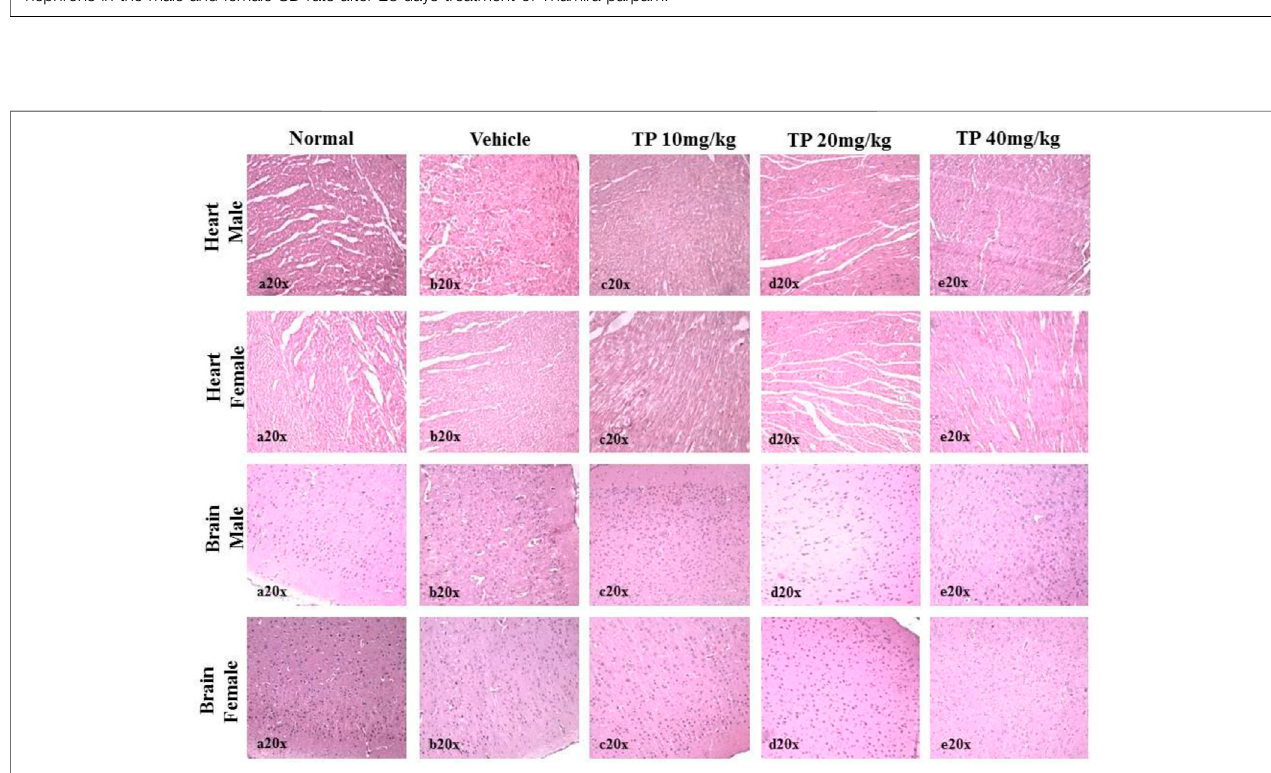
FIGURE 12 | Histopathological analysis of heart and brain tissues showing no abnormalities in the male and female SD rats after 28 days treatment of Thamira Parpam.